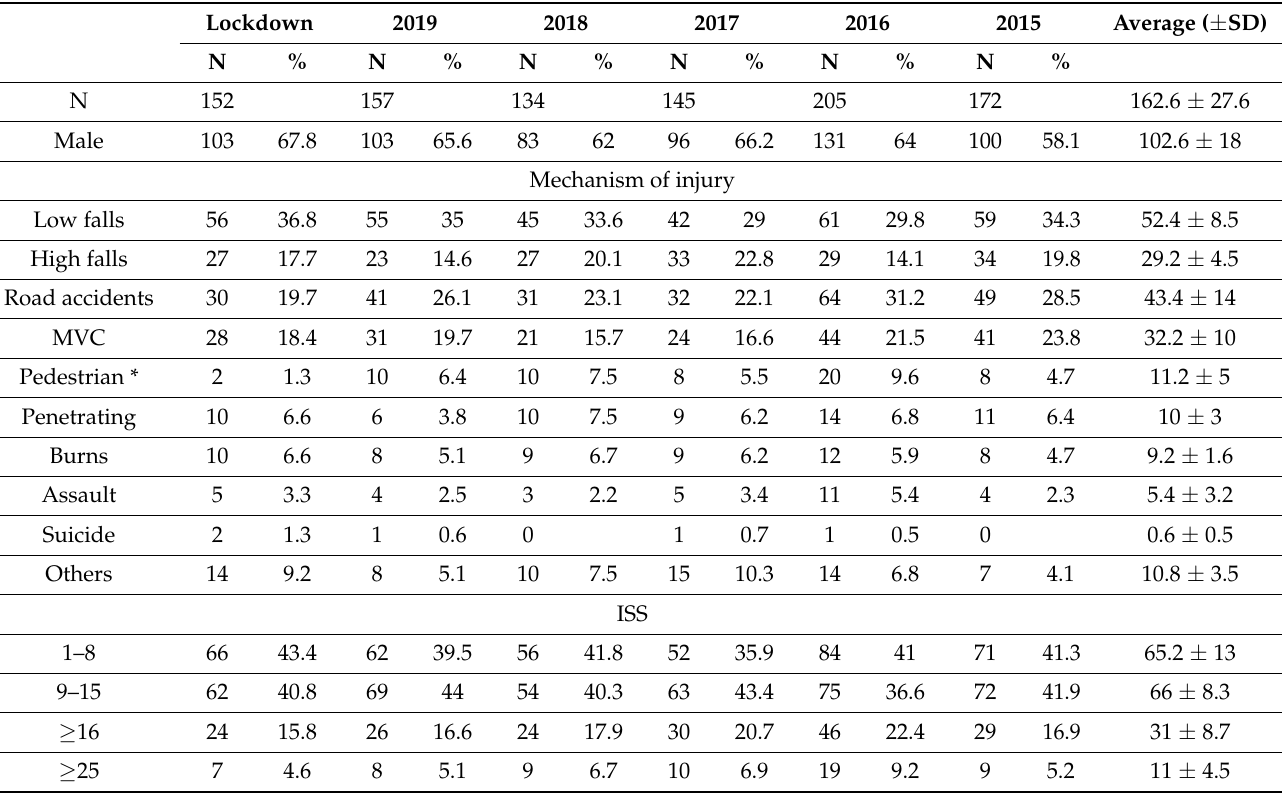
Table 1. Demographic, incidental and hospital resources utilization characteristics of the hospitalized injured patients during the lockdown period (March 25 2020 through to April 19 2020) and control periods (1 to 25 April